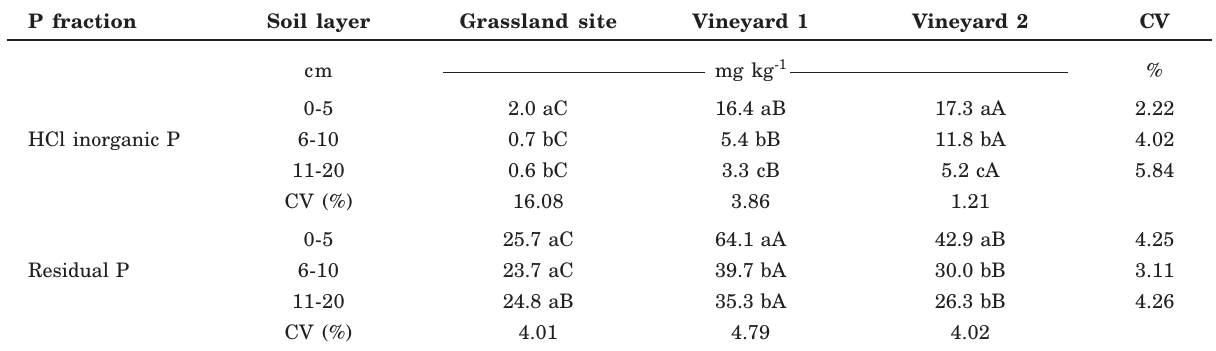
Mean values followed by the same letter in the column and mean values followed by the same capital letter in the row, comparing soil layers, are not significantly different (Tukey test, p<0.05).